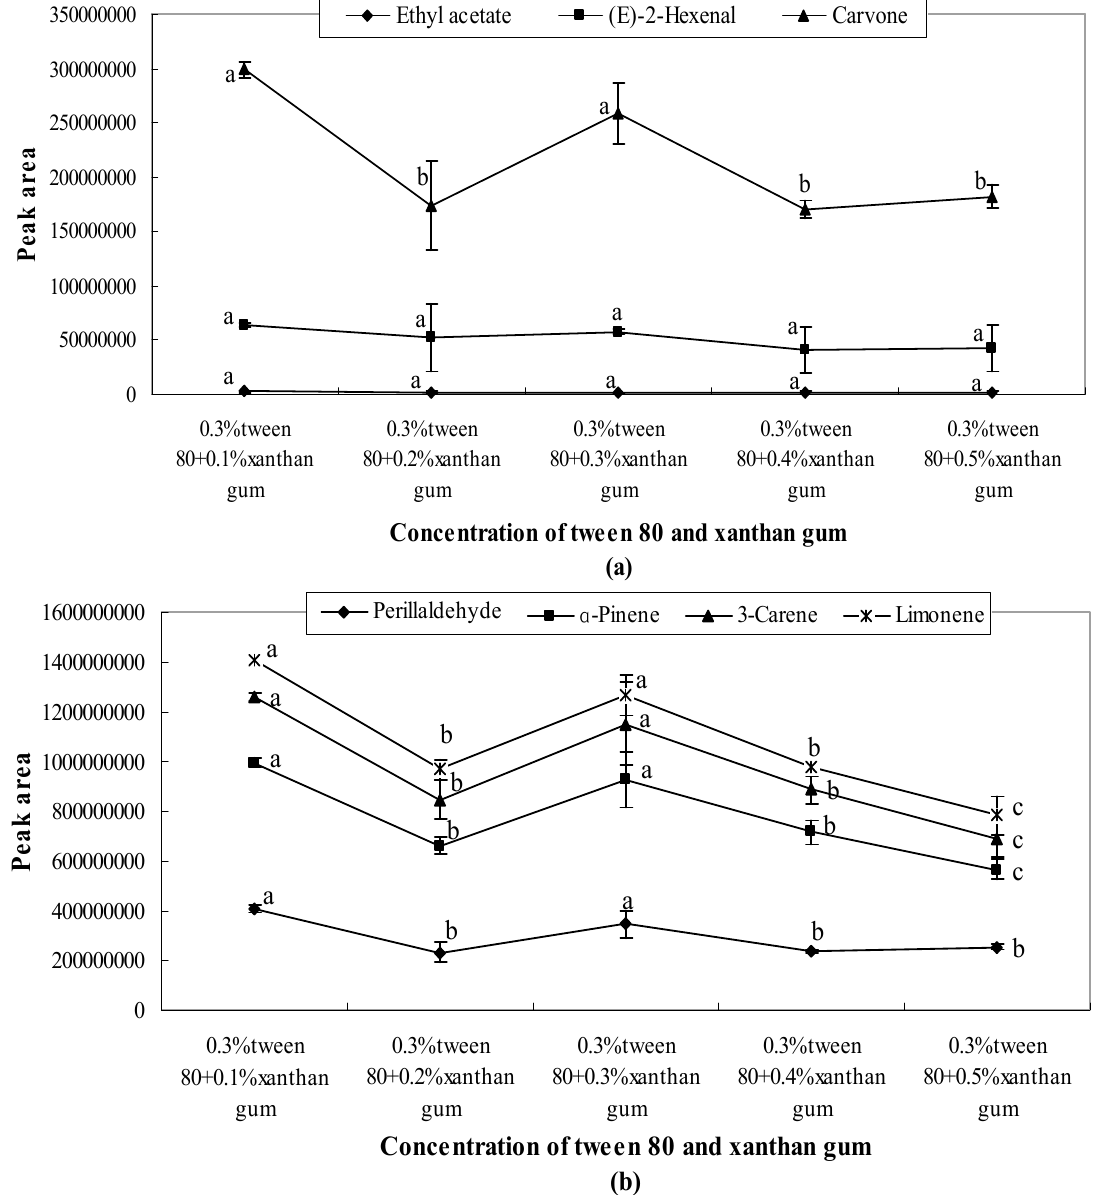
Figure 5. Effects of Tween 80 and xanthan gum on the release of ethyl acetate, ( E )-2-hexenal, carvone ( a ) and perillaldehyde, α -pinene, 3-carene, limonene ( b ). Significant differences ( p < 0.05) between different concentrations are performed by letters on the same polylines. Where the letters on the same polyline are the same, there is no significant difference between different concentrations.